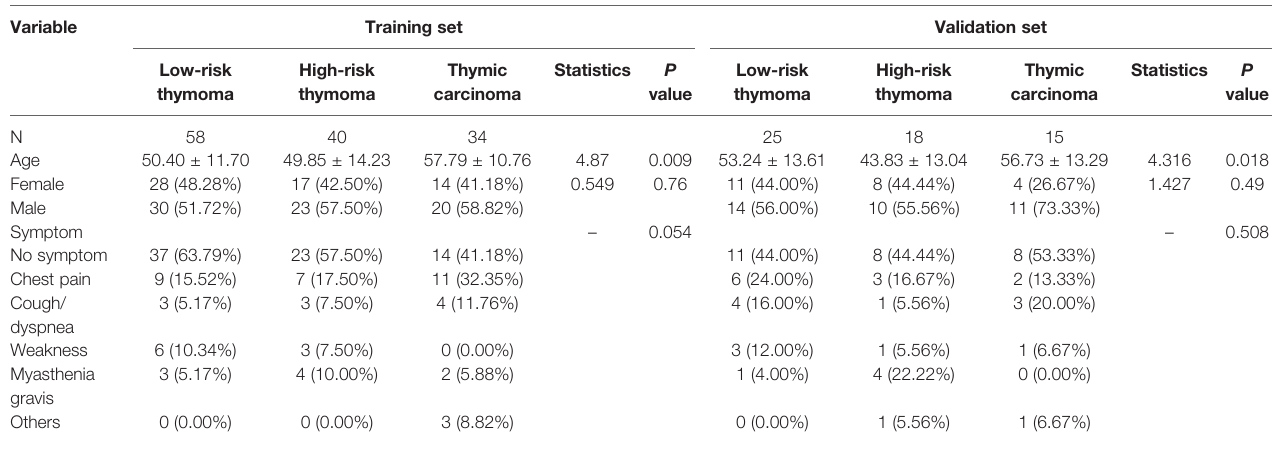
TABLE 1 | Clinical characteristic of